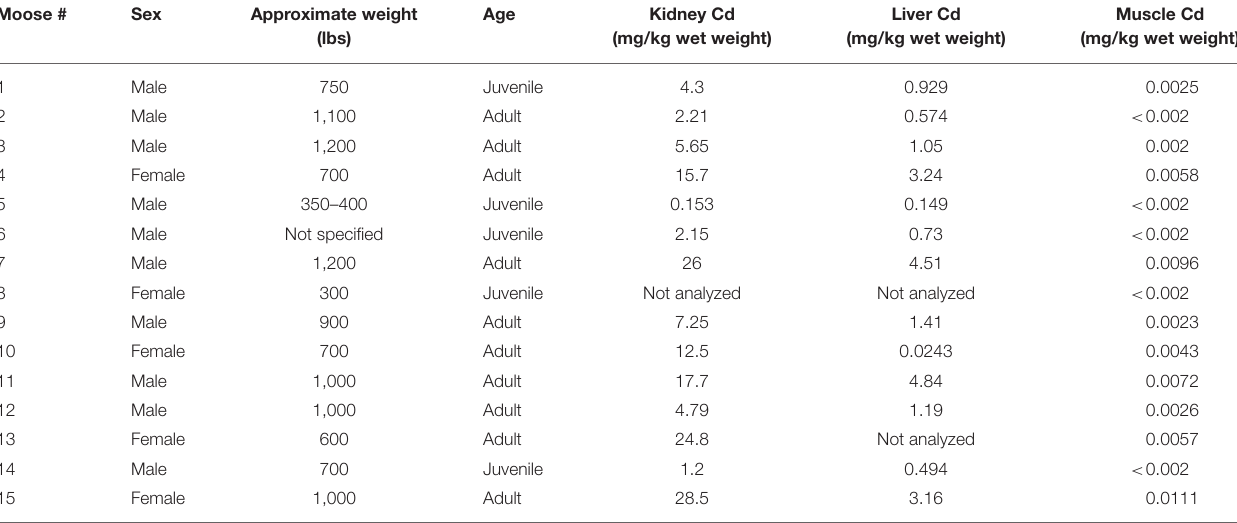
TABLE 3 | SRFN Moose Details (sex, age, weight, and tissue